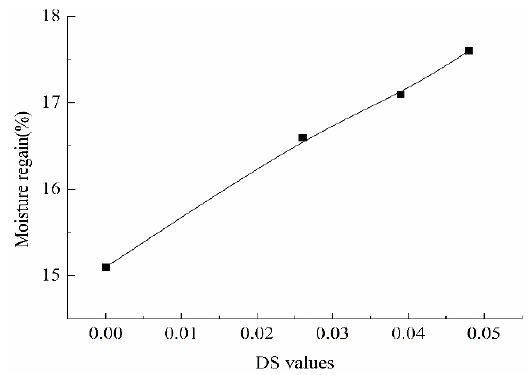
Figure 8. Influence of quaternization/hydroxypropylsulfonation on moisture regain of OTS films.